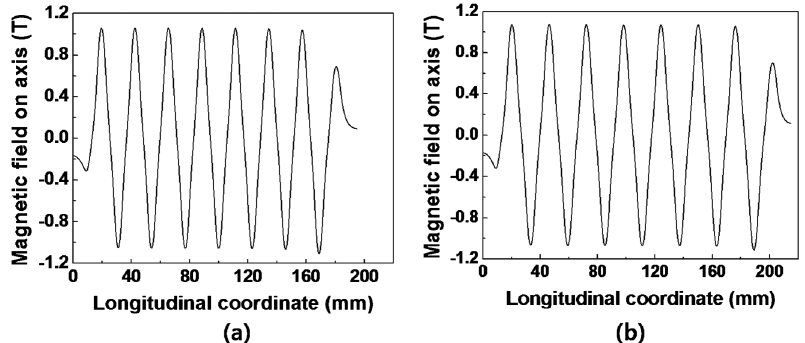
FIG. 2. Calculated vertical component of the on-axis magnetic field of the V-P helical undulator. The short undulator with seven ¼ 23 mm and (b) λ ¼ 26 mm. The calculated peak magnetic field is about 1 periods was simulated for (a) λ w w